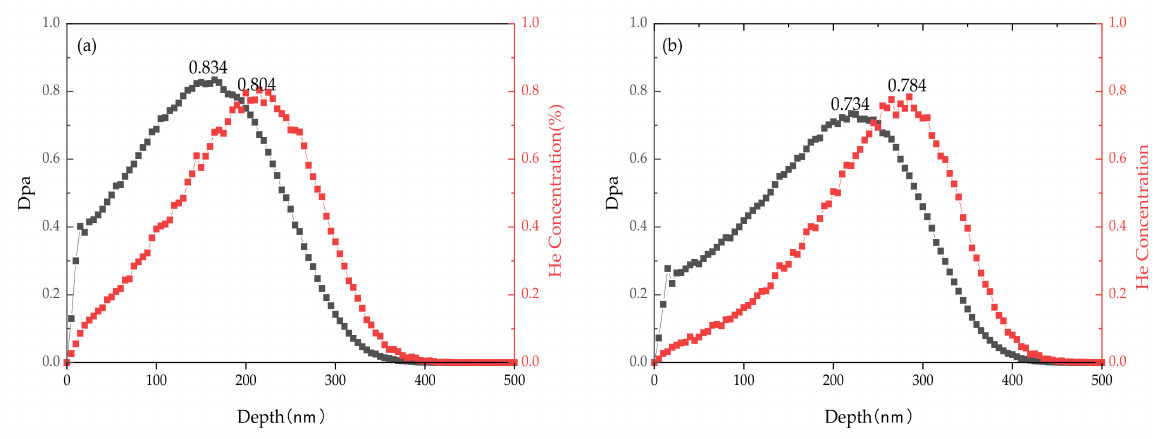
Figure 3. SRIM-simulation calculation of the (TiCrV)x-(TaW)1-x (A-M) binary system HEA films. The implanted particles were He+ ions, the energy was 70 KeV, and the dose was 1 × 1016 ions/cm 2 . The black line is the radiation damage, and the red line is the deposited He+ ion concentration: ( a ) Sample C, Ta30W30Ti12V15Cr13, and ( b ) Sample K,